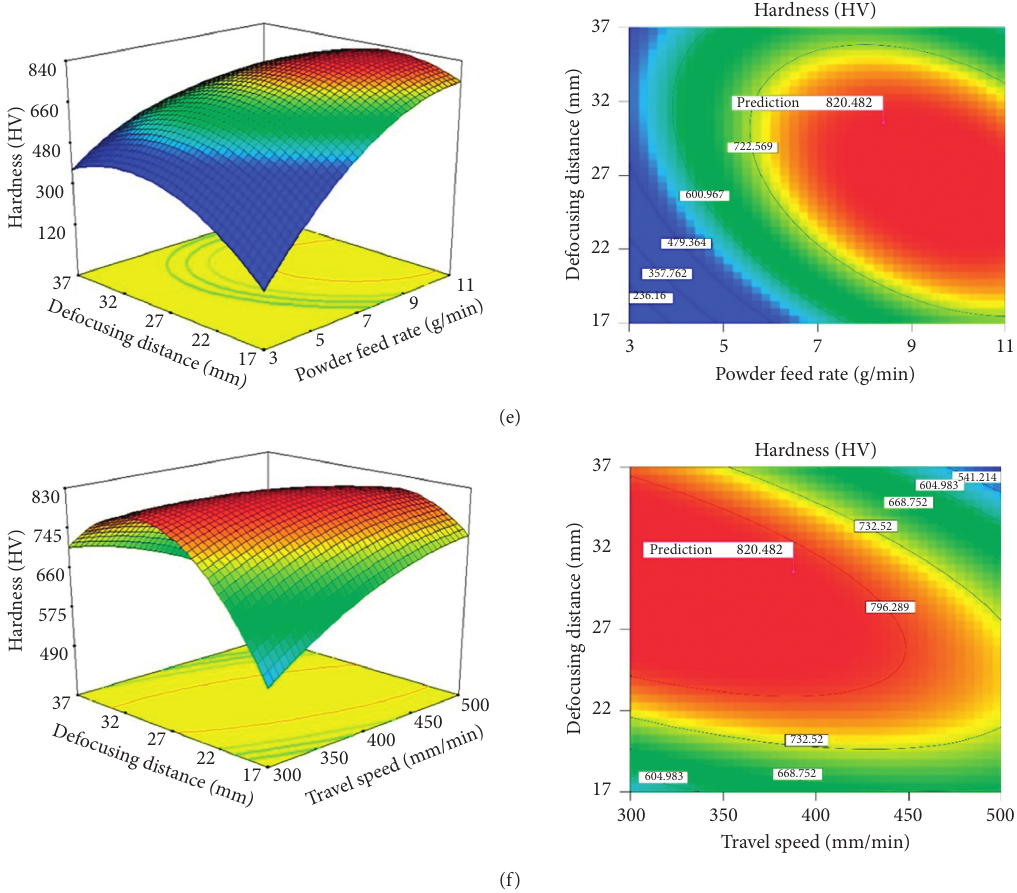
Figure 6: Response surface graphs and contour plots. The interaction between (a) laser power and powder feed rate, (b) laser power and travel speed, (c) laser power and defocusing distance, (d) powder feed rate and travel speed, (e) powder feed rate and defocusing distance, and (f) travel speed and defocusing distance is